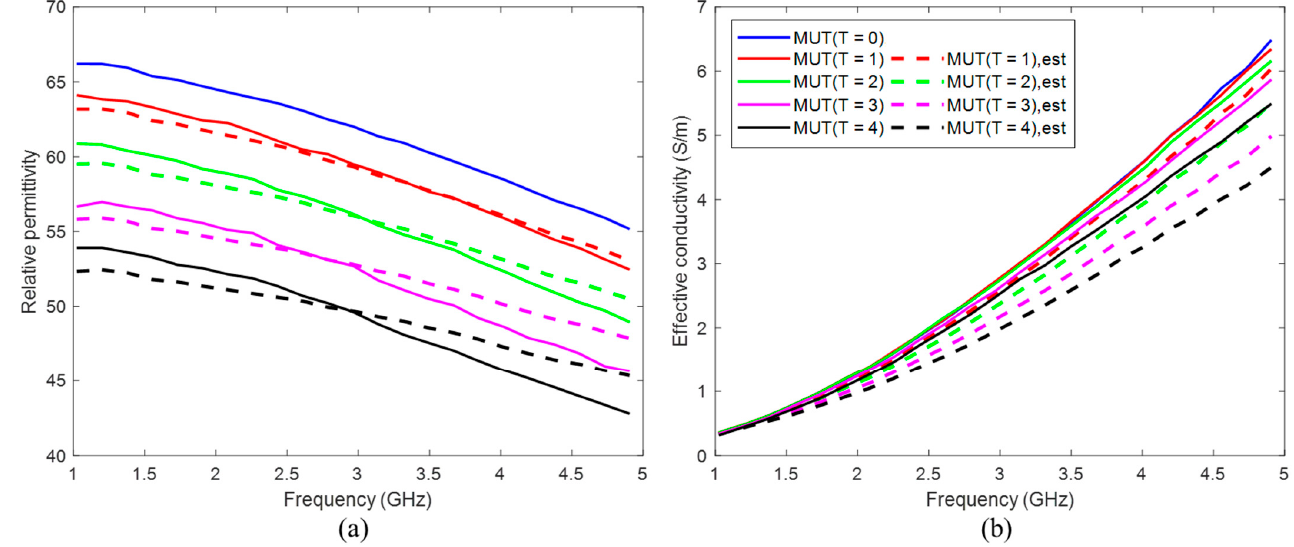
Figure 9. Estimated mean relative permittivity ( a ) and effective conductivity ( b ) in the 3D tumor area as function of frequency (dashed lines) and measured by means of dielectric spectroscopy (solid lines).